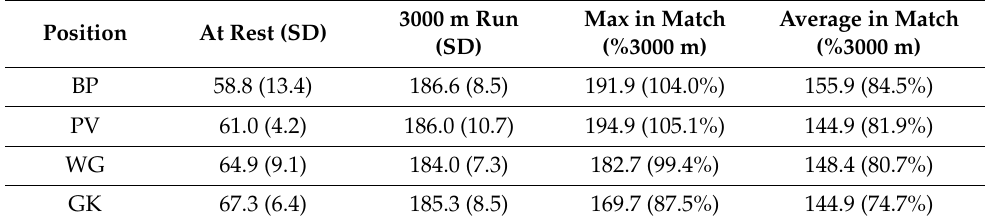
3000 m Run Max in Match (SD) (%3000 m)